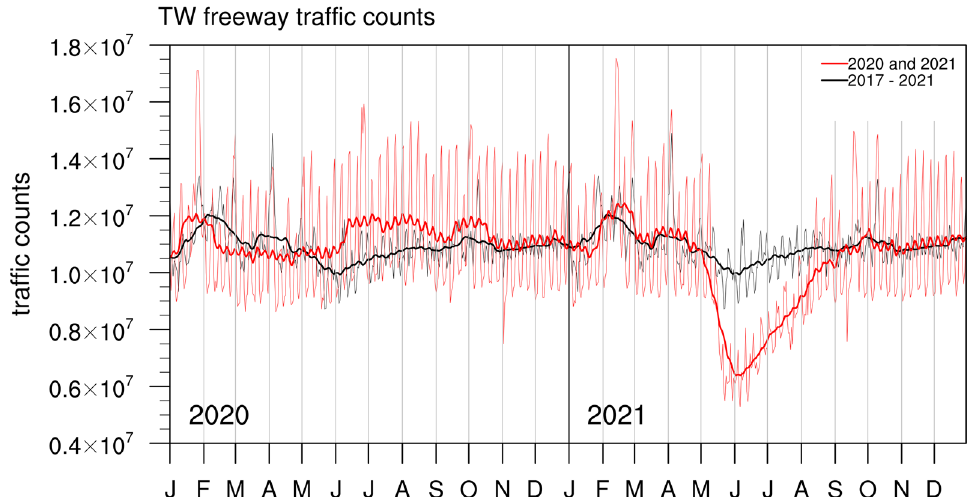
Fig. 6 Variations of the daily freeway traffic volume collected by the ETC (thin line) on the freeways with its 31‑day running mean (bold line). The 5‑year mean values (2017–2021) are shown in black lines and the values in 2020–2021 are shown in red lines. Shaded areas denote the period of the Level 3